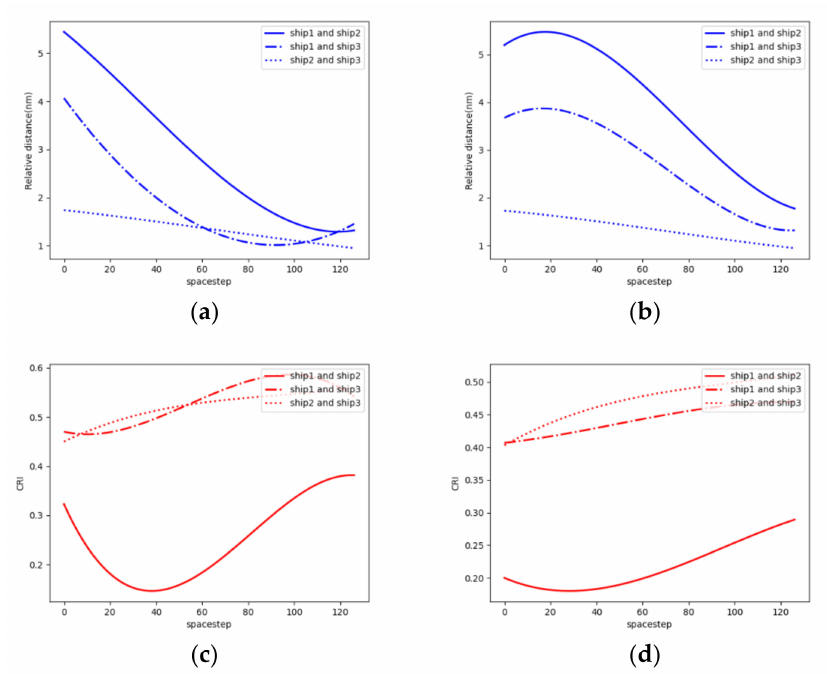
Figure 19. Three-ship encounter comparison.